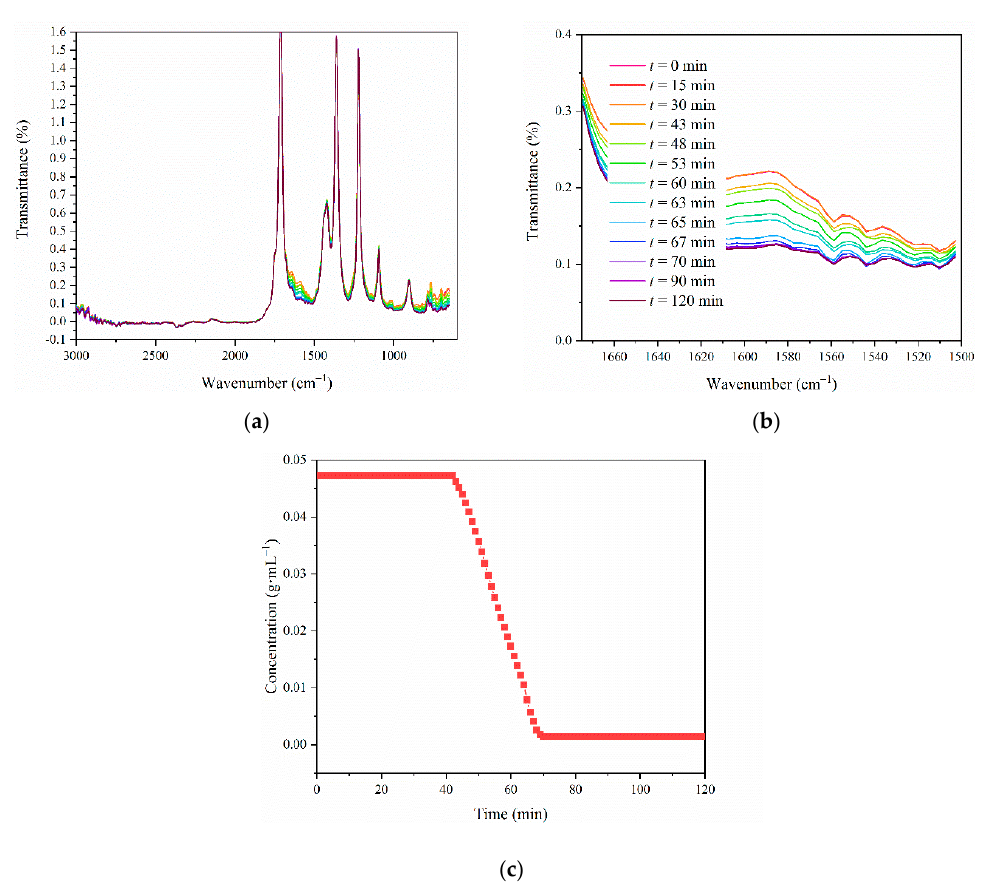
Figure 13. Variation of ATR-FTIR spectra during the co-crystallization of LCZ696 in the regions of ( a ) 3000~1500 cm − 1 , ( b ) 1675~1500 cm − 1 ; ( c ) the concentration variation of sacubitril during the co-crystallization of LCZ696.